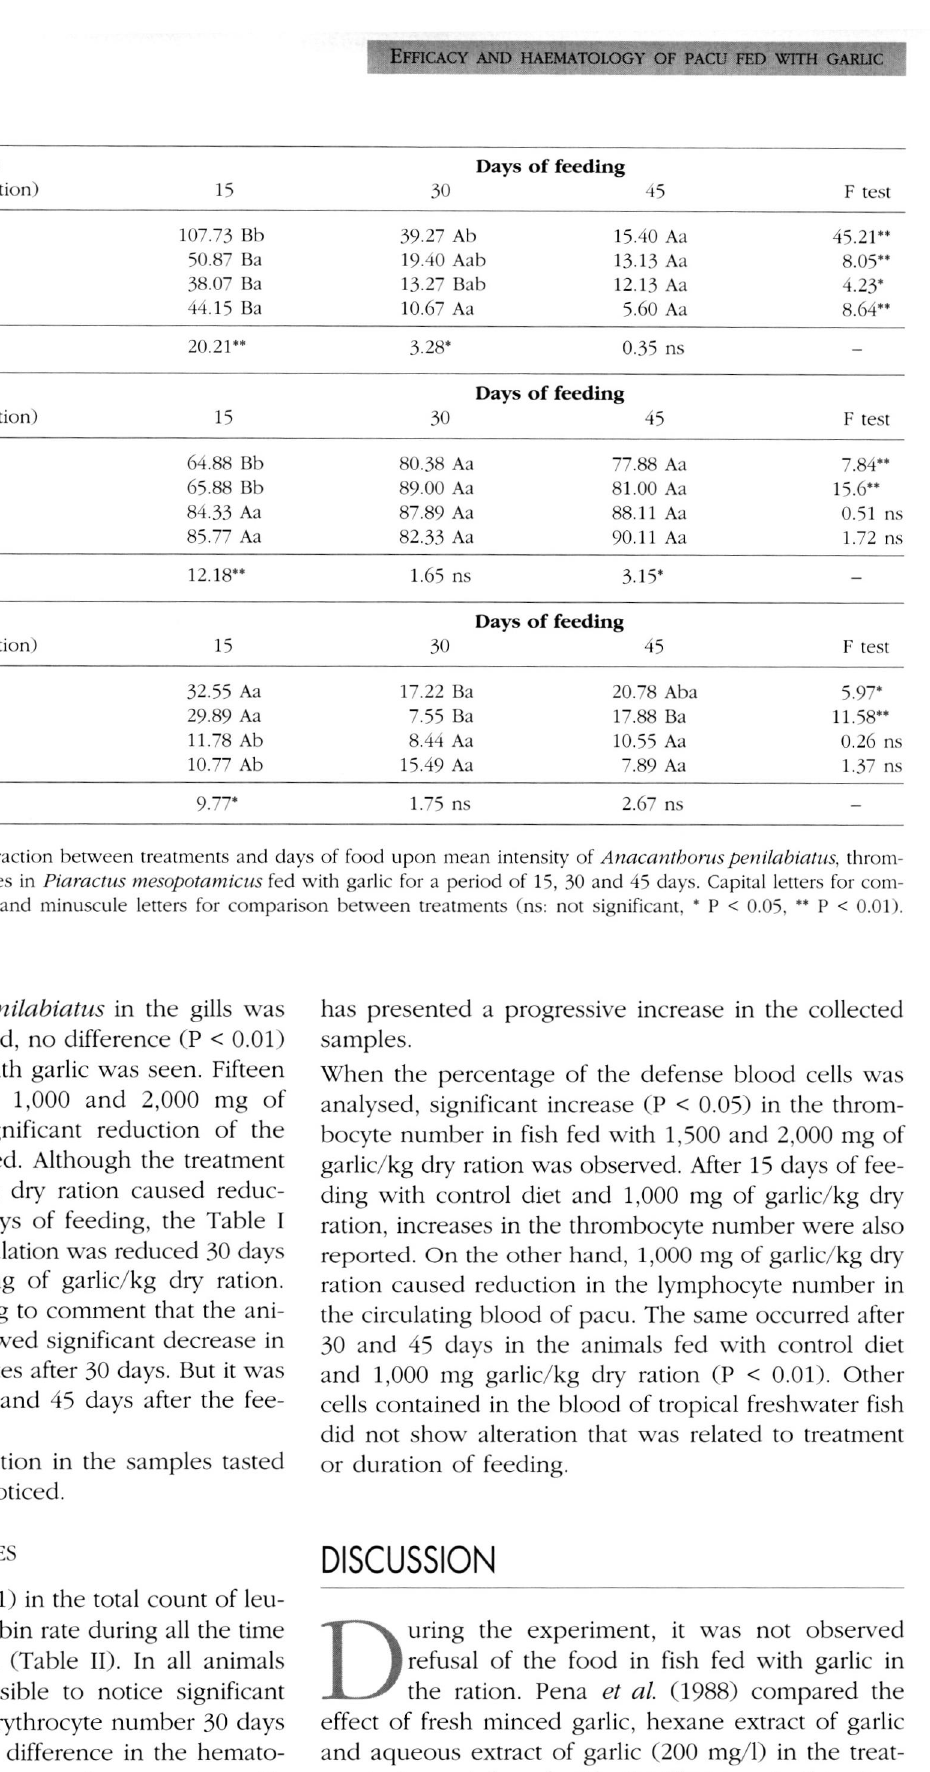
Treatment (mg of garlic/kg dry ration)